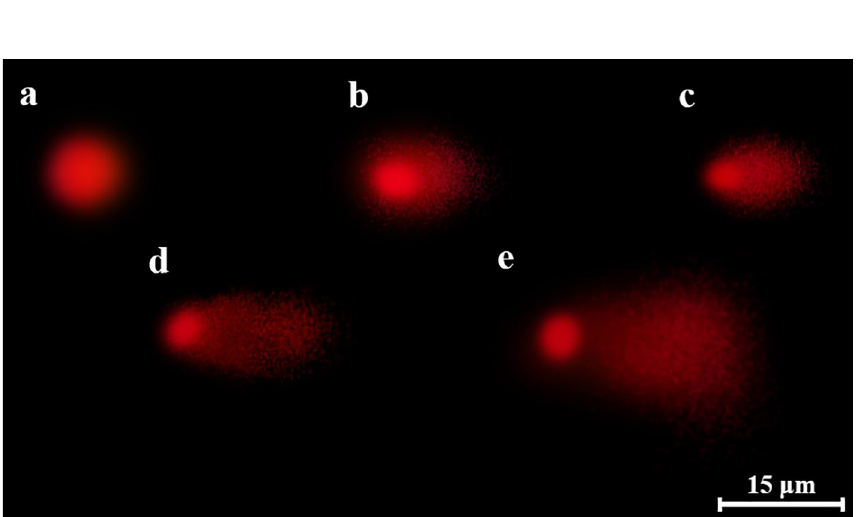
Figure 4. Effects of penoxsulamon DNA in A. cepa root tip cells ( a no damage, b low damage, c moderate damage, d high damage, e extreme damage. Scale bar = 15